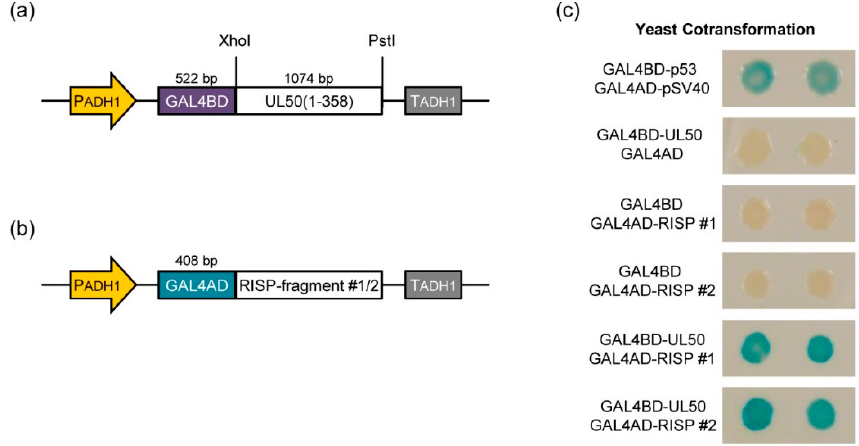
Figure 3. Yeast two-hybrid assay with pUL50 as bait. ( a ) Bait construct yielding a GAL4 binding domain-pUL50 fusion protein, used for screening and cotransformation. PADH, alcohol